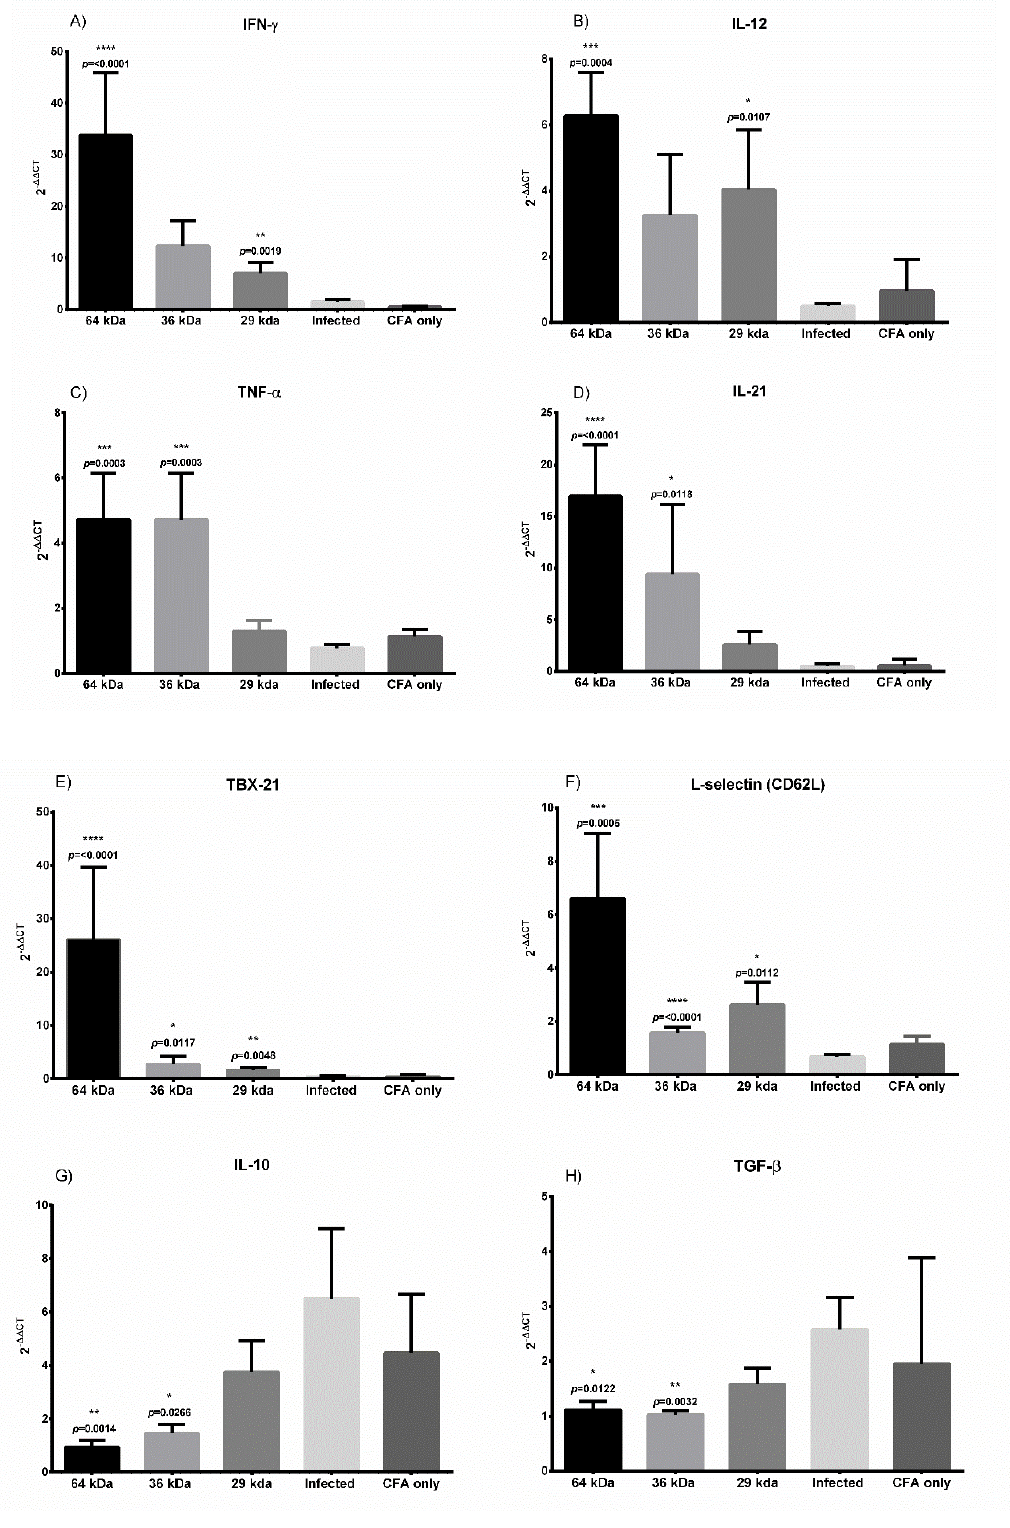
Figure 5. Relative fold change in gene expression levels of ( A ) IFN- γ , ( B ) IL-12, ( C ) TNF- α , ( D ) IL-21, ( E ) TBX21, ( F ) L selectin, ( G ) IL-10, and ( H ) TGF- β from immunized and unimmunized animal’s spleen. n = 8 for 64 kDa and 36 kDa, n = 7 for 29 kDa and n = 5 for the infected. Mean values ± SEM. Statistical comparison between infected and test group, Student’s t -test. Level of significance, ns p > 0.05, * p ≤ 0.05, ** p ≤ 0.01, *** p ≤ 0.001, **** p ≤ 0.00001.